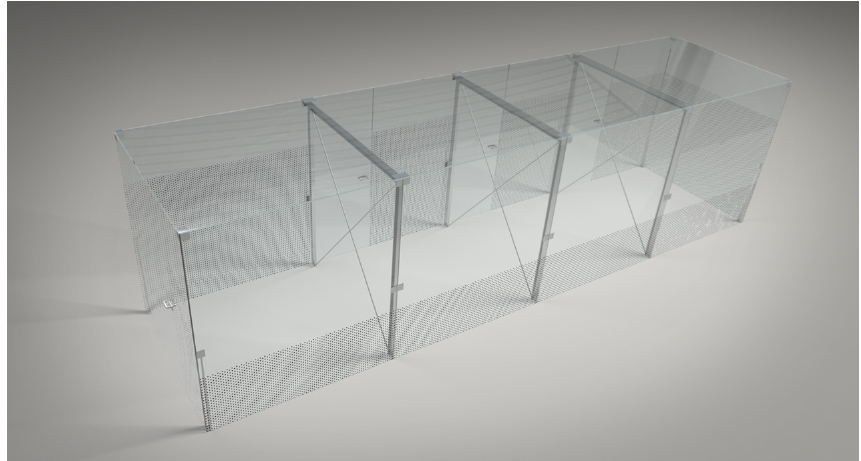
Figure 7: Rendering of the cubicles located inside the reading hall (© Werner Sobek